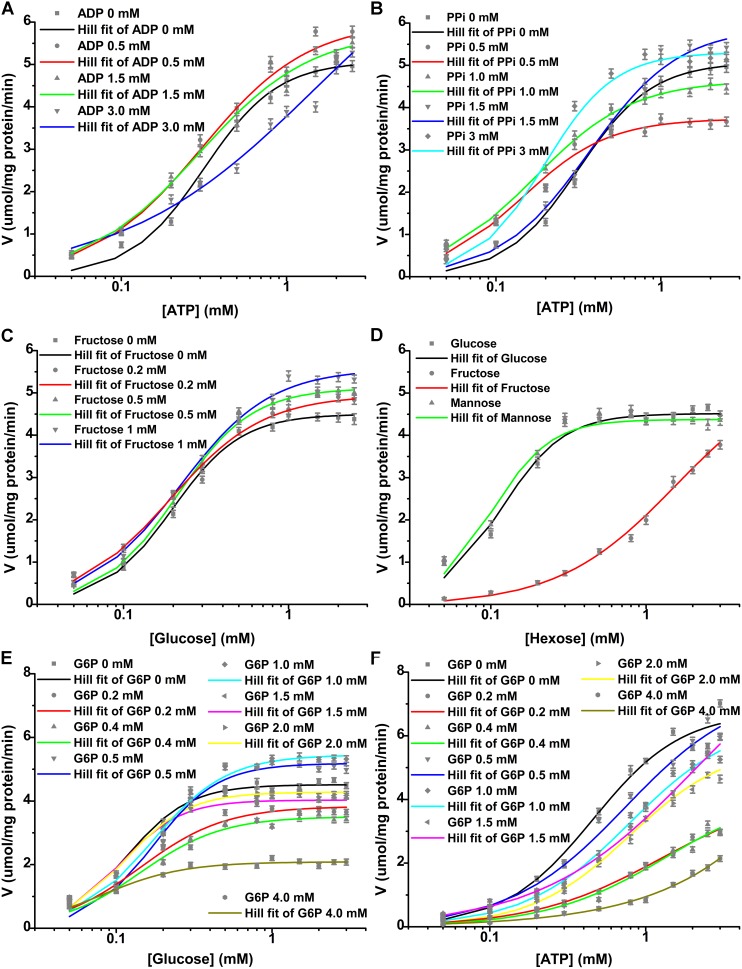
Enzymatic activity of rCsHK with respect to different substrates or effectors.(A) The effect of 0∼3.0 mM ADP and fixed 3.0 mM glucose with respect to ATP in reaction system A. (B) The effect of 0∼3.0 mM PPi and fixed 3.0 mM glucose with respect to ATP in reaction system A. (C) The effect of 0∼1.0 mM fructose and fixed 3.0 mM ATP with respect to glucose in reaction system A. (D) The effect of 0∼3.0 mM hexoses (glucose, fructose and mannose) and fixed 3.0 mM ATP in reaction system B. (E) The effect of 0∼4.0 mM G6P and fixed 3.0 mM ATP with respect to glucose in reaction system B. (F) The effect of 0∼4.0 mM G6P and fixed 3.0 mM glucose with respect to ATP in reaction system B.